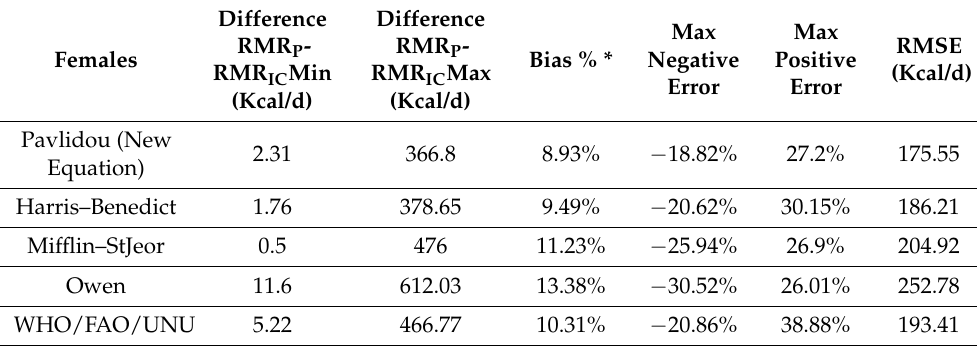
Table 4. Evaluation of selected predictive equations in 127 women based on differences Predicted (RMR P )-Measured (RMR IC ), percentage of accuracy, Bias, and Root Mean Square Error.